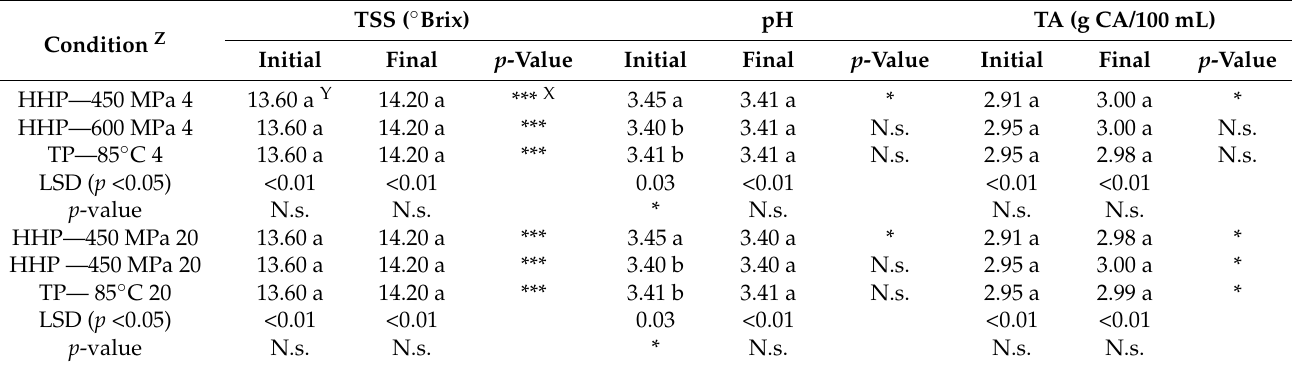
Table 4. pH, titratable acidity (TA), and total soluble solids (TSS) measured at day 0 (initial) and after 90 days of storage (final) for beverages subjected to HHP and TP and stored under two different